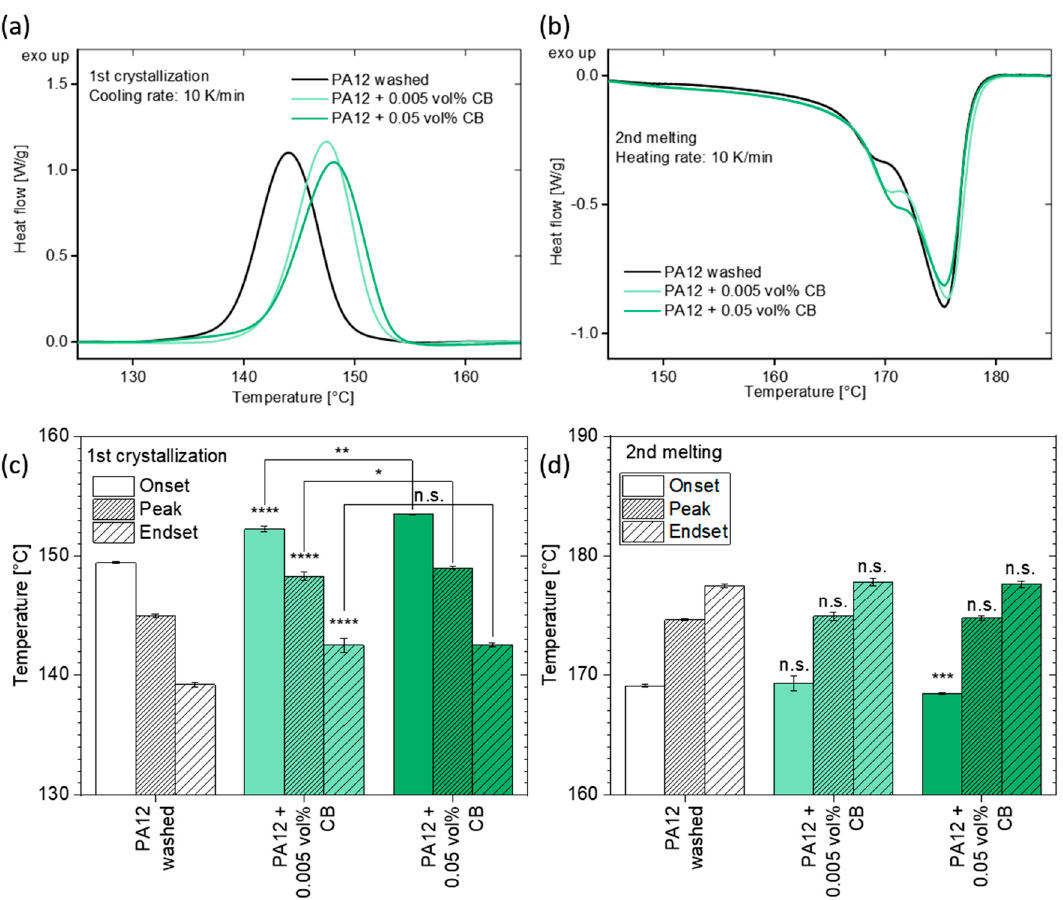
Figure 9. DSC analysis of PA12 powder before and after colloidal additivation with the laser-generated carbon nanoparticles: ( a ) 1st crystallization and ( b ) 2nd heating curves, based on the average of 3 runs. ( c , d ) Extracted onset, peak, and endset temperatures with corresponding error bars. The analysis of statistical significance either shows no significant difference (n.s.; p > 0.05) or a significant difference, where the p -values decrease with the increasing number of asterisks.